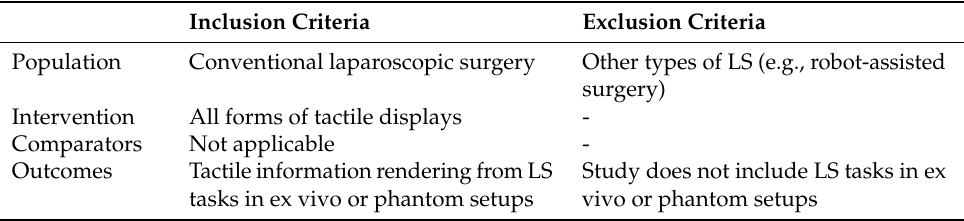
Table 1. PICO framework for the definition of research question and inclusion/exclusion criteria. Inclusion Criteria